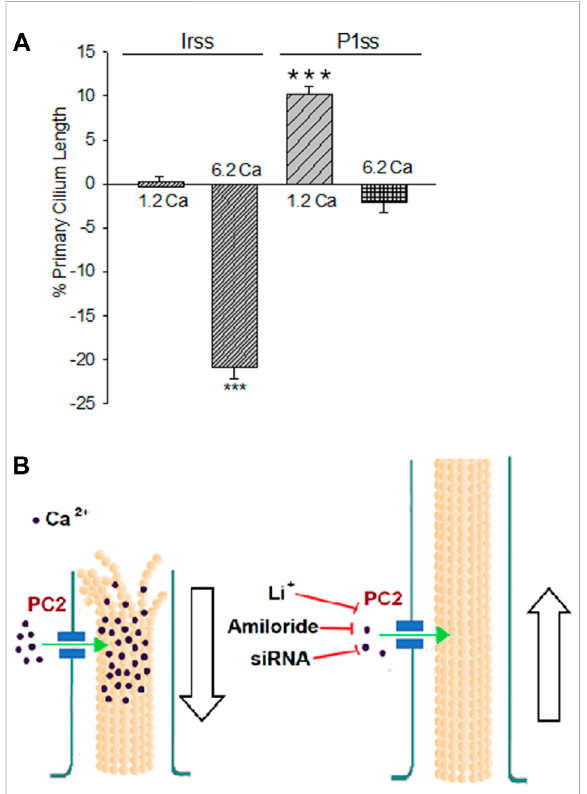
Differences in the primary cilium length after inhibition of PKD2 gene expression. (A) Bar graphs represent either the percent increase (positive bars) or decrease (negative bars) of the length of the primary cilium of LLC-PK1 cells in normal (1.2 mM) and high (6.2 mM) external Ca 2+ concentrations. Data were made relative to the Irss 1.2 mM Ca 2+ , control condition with the scrambled silencing RNA probe (Irss). Irss-treated cells responded to high external Ca 2+ with a signi fi cant decrease in the primary cilium length. Ciliary length of PKD2 -silenced cells increased to the respective controls in the presence of both normal (1.2 mM) and high (6.2 mM) external Ca 2+ . Asterisks (***) indicate statistical signi fi cance at p < 0.001 vs. Irss control, evaluated by one-way ANOVA. (B) Cartoon of the possible role(s) PC2 plays in regulating the primary cilium length in LLC-PK1 renal epithelial cells. Under normal external Ca 2+ conditions (1.2 mM), the primary cilium length is maintained by PC2-mediated Ca 2+ entry. In a high external Ca 2+ (6.2 mM) concentration, the increased intraciliary Ca 2+ would help depolymerize axonemal microtubules, reducing their length and thus the primary cilium. Either PC2 inhibition (by Li + or amiloride) or reduction of its expression (siRNA) would instead contribute to reducing Ca 2+ entry to the primary cilium, also decreasing the rate of MT depolymerization, rendering longer primary